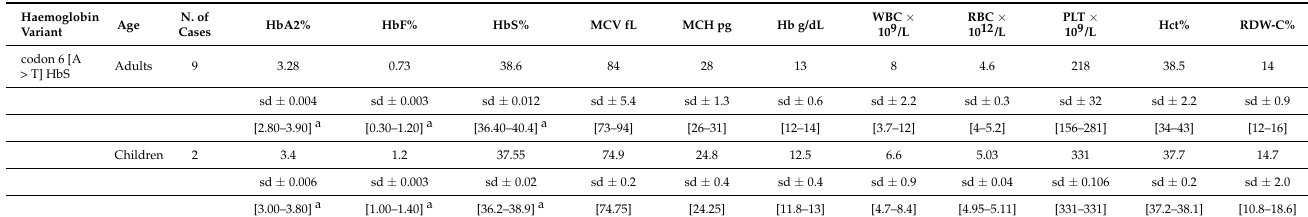
Table 5. Hematologic parameters (mean values and Standard Deviation (SD)) observed in subjects were carriers of HbS haemoglobin variant.